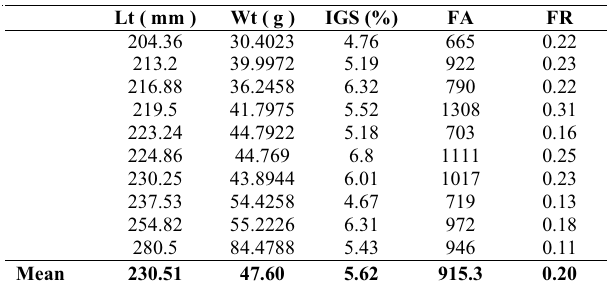
index (IGS), absolute fecundity (FA) and relative fecundity (FR) of 10 Gymnotus aff. carapo females in lake Verde, Itapuã State